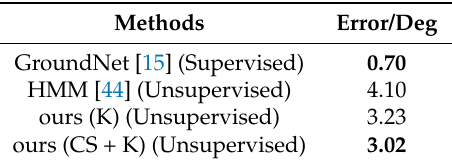
Figure 9. ( a ) is the original image. The red arrow denotes our predicted ground normal vector, and the blue one is the groundtruth calculated using extrinsic parameters. ( b ) is the BEV image transformed using our predicted normal vector while ( c ) is the BEV transformed using the groundtruth normal vector. The parallelism of the lane lines near the red circle is relatively low, indicating that the groundtruth value is sometimes not accurate enough. Table 3. Comparison of normal vector estimation. The groundtruth value is calculated using extrinsic parameters. K means only using KITTI raw data for training, and CS + K means using Cityscapes and KITTI raw data.